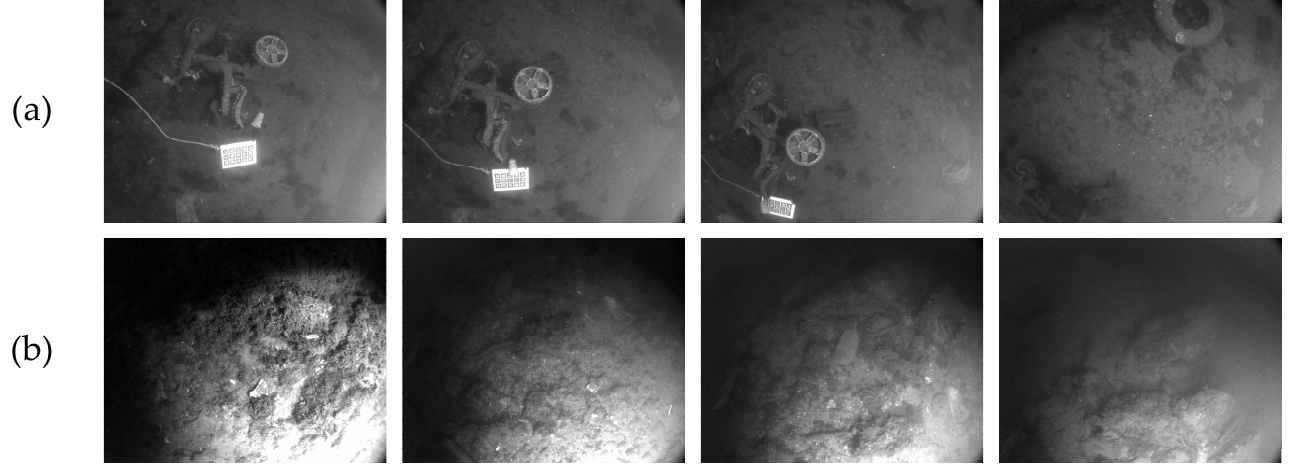
Figure 5. Example images of the public dataset AQUALOC. ( a ) is the example image of sequence 1, while ( b ) is the example image of sequence 7. Table 1. Vision-only methods positioning accuracy